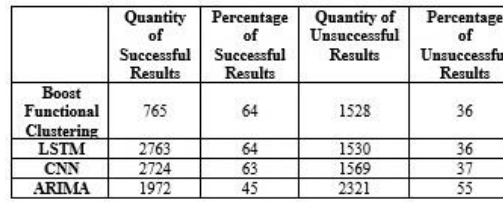
Table 5: 2003-2020 2019 USD/TRY Application Test Results